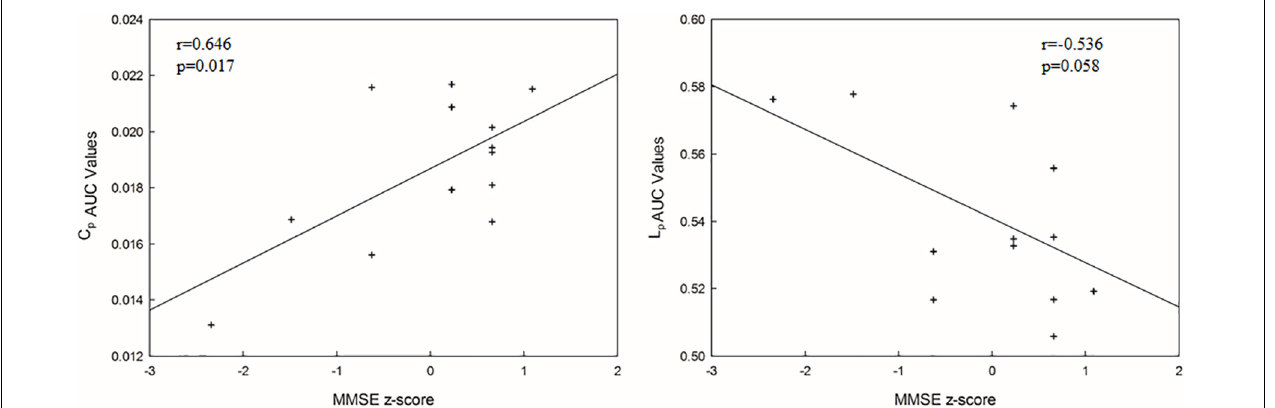
FIGURE 5 | The correlations between each AUC network metric value and MMSE score ( p < 0.05). C p , clustering coefficient; L p , mean path